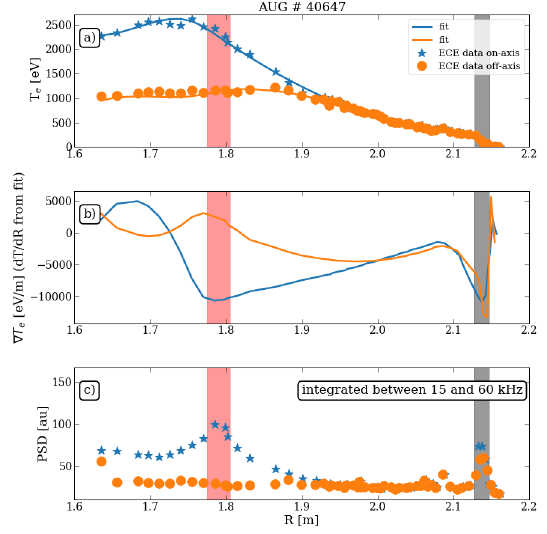
Figure 7. AUG #40647 profiles for the two di ff erent heating schemes. On-axis ECRH heating is shown in blue while o ff - axis is shown in orange. a) Profile of the electron temperature T e measured with ECE in symbols and the corresponding fits in solid lines. b) Gradients of the electron temperature fits. c) Amplitude distribution of Fourier filtered data between 15 and 60kHz. The two shaded regions correspond to the maximum perturbation amplitude in the core (in red) and at the edge (in black).